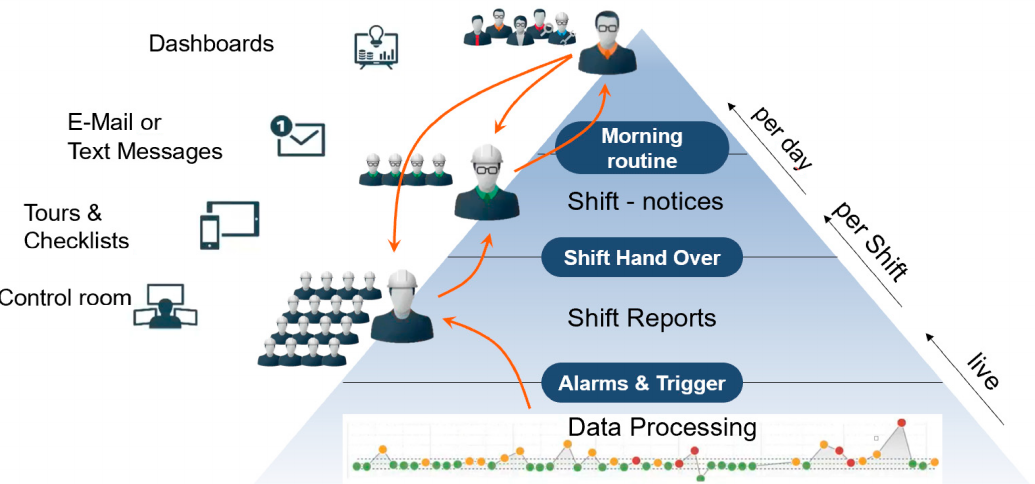
Figure 22. Significance of the automation levels using the example of reporting (own